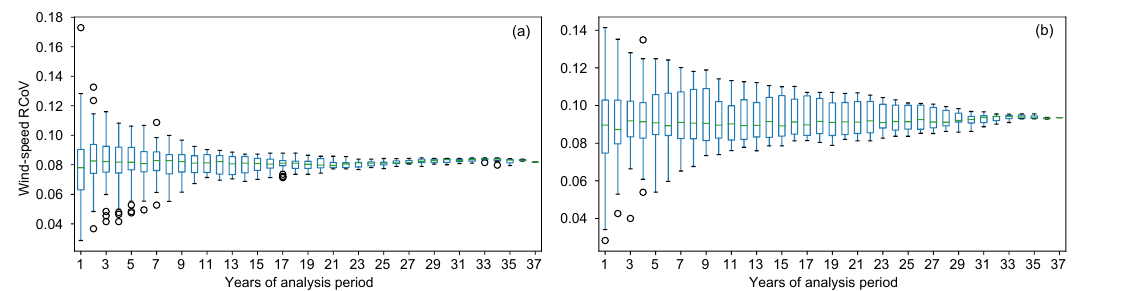
Figure 8. Box plots of wind-speed RCoV using monthly MERRA-2 data for different time frames from 1 year to 37 years at (a) the OR site and (b) the TX